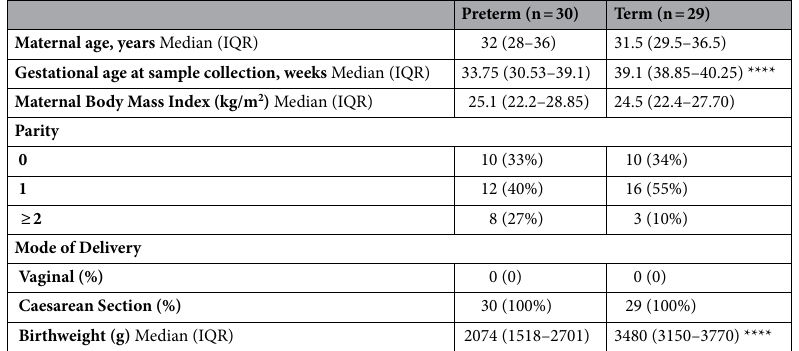
Table 2. Patient characteristics for placental tissue used to assess NR4A2 expression between preterm and term gestation. Maternal age unavailable for n = 1 term sample. BMI data unavailable for n = 6 preterm samples. **** p < 0.0001.